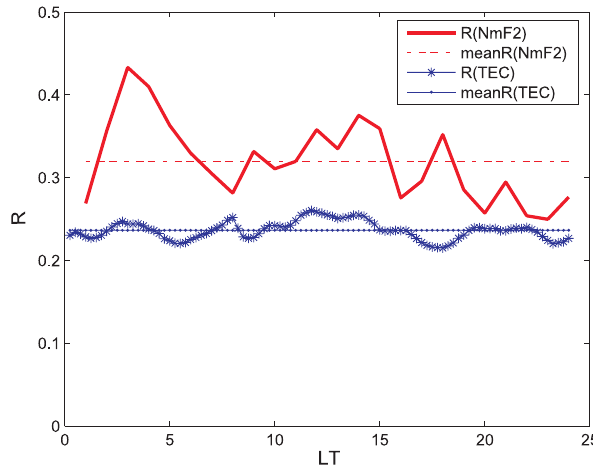
Fig. 8. Relative ranges of day-to-day variations of both TEC and Nm F2 with LT at